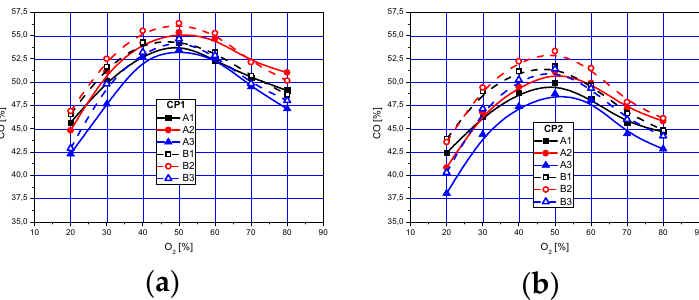
Figure 7. Changes in averaged values of molar fractions of CO in the planes CP1 ( a ) and CP2 ( b ) with respect to oxygen concentration for variants A1 , A2 , A3 , B1 , B2 , B3 .